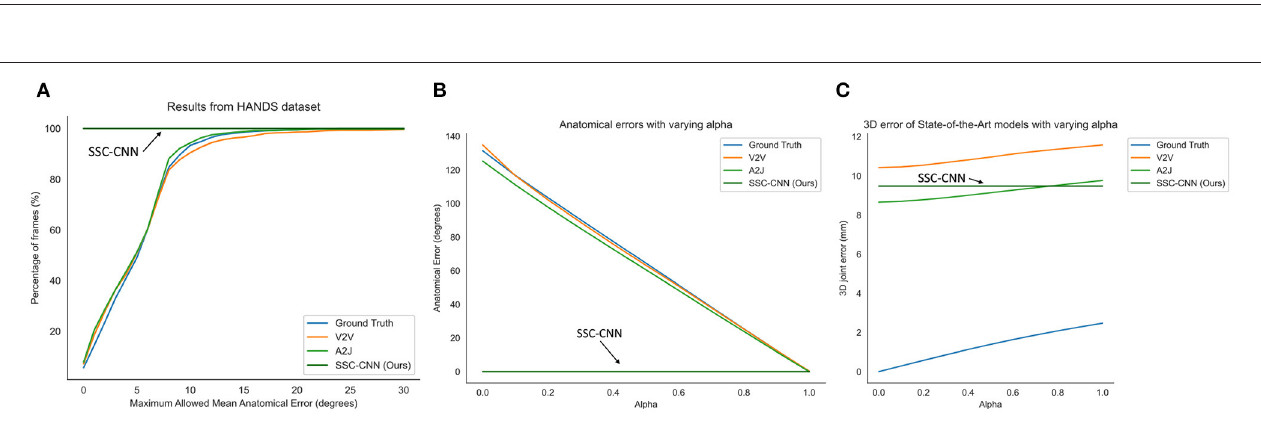
FIGURE 5 | Comparison of the anatomical errors and the 3D joint errors of various state-of-the-art models along with our proposed model using the MSRA hand dataset (A,C) . The ground truth is also shown for comparison as it has high anatomical errors (B) . The error can be due to the noises during the recording of the lab.